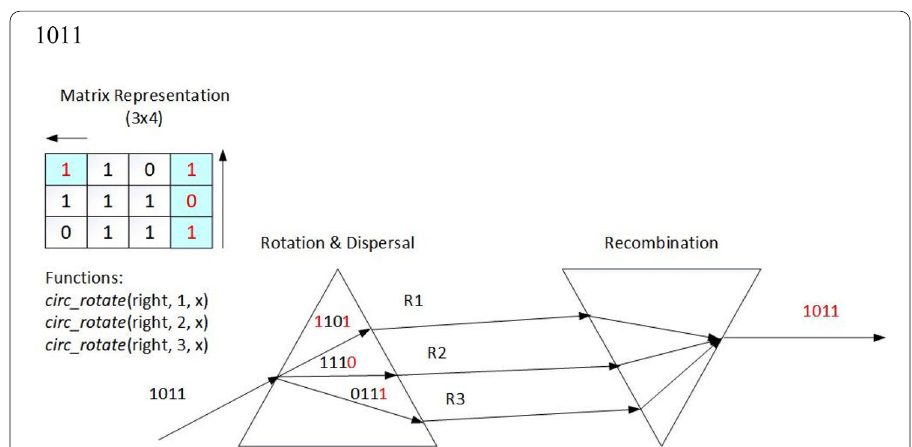
Fig. 10 Passing the classical bit string 1011 through the bit